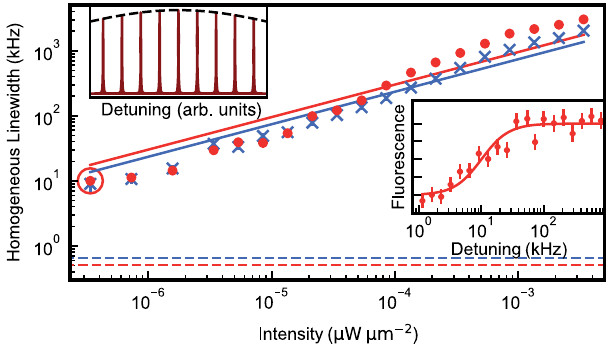
FIG. 4. Homogeneous linewidth measurement. Top left inset: measurement scheme. The laser is modulated to generate a comb of up to 27 lines with equal separation and amplitude, exciting many subensembles (brown) within the inhomogeneous line of the dopants (dashed line). When the modulation frequency is smaller than the linewidth of the subensembles, saturation leads to a signal decrease (right inset), which is well fit by Lorentzian curves (red solid line) with FWHM down to 18(6) kHz for site A (blue) and 20(4) kHz for site B (red). An upper bound for the homogeneous linewidth is given by half the width of the transient hole (main graph, CVD sample, red and blue data). The data ffiffi p I exhibit a scaling (lines) down to the lowest intensity that provides sufficient signal to noise (red circle, shown as inset). This indicates that the measured linewidth is determined by power broadening and thus constitutes an upper bound to the homogeneous linewidth of erbium dopants in the investigated nanophotonic silicon